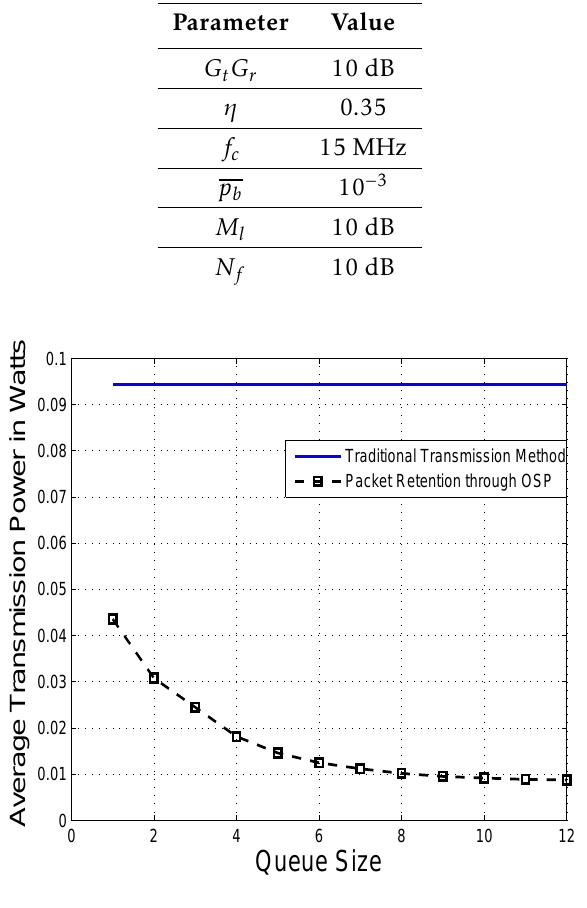
Figure 1. Power Saving through